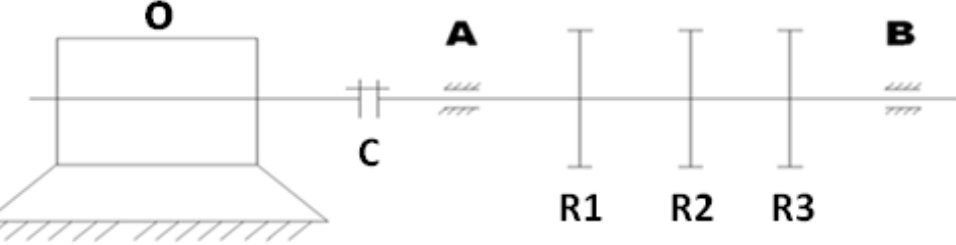
Figure 4. Diagram of the bearing